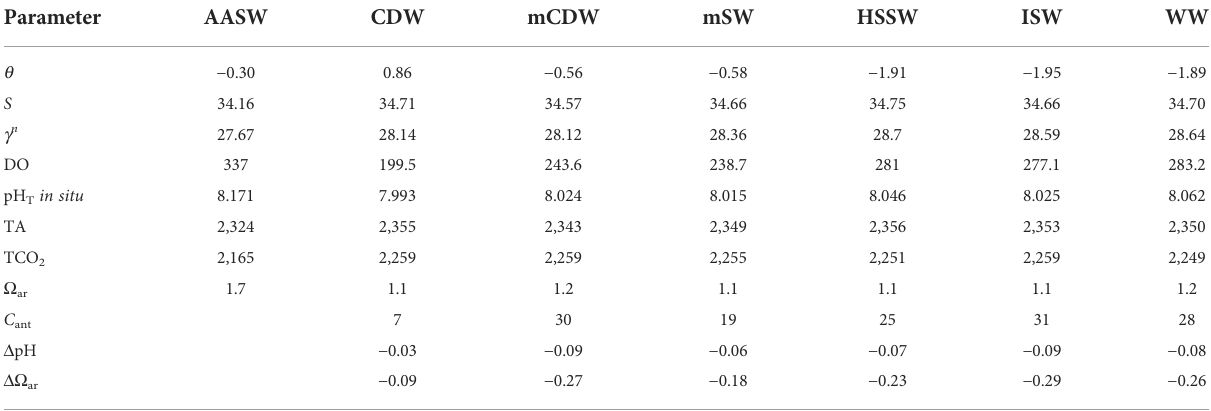
TABLE 1 Estimated mean values of potential temperature ( q ; °C), salinity ( S ), neutral density anomaly ( g n ; kg m − 3 ), dissolved oxygen concentration (DO; m mol kg − 1 ), total alkalinity (TA; m mol kg − 1 ), total dissolved inorganic carbon concentration (TCO 2 ; m mol kg − 1 ), pH T at in situ temperature (pH